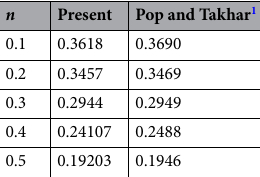
Table 1. The comparison of obtained results for Pr = 1.0 by keeping other parameters